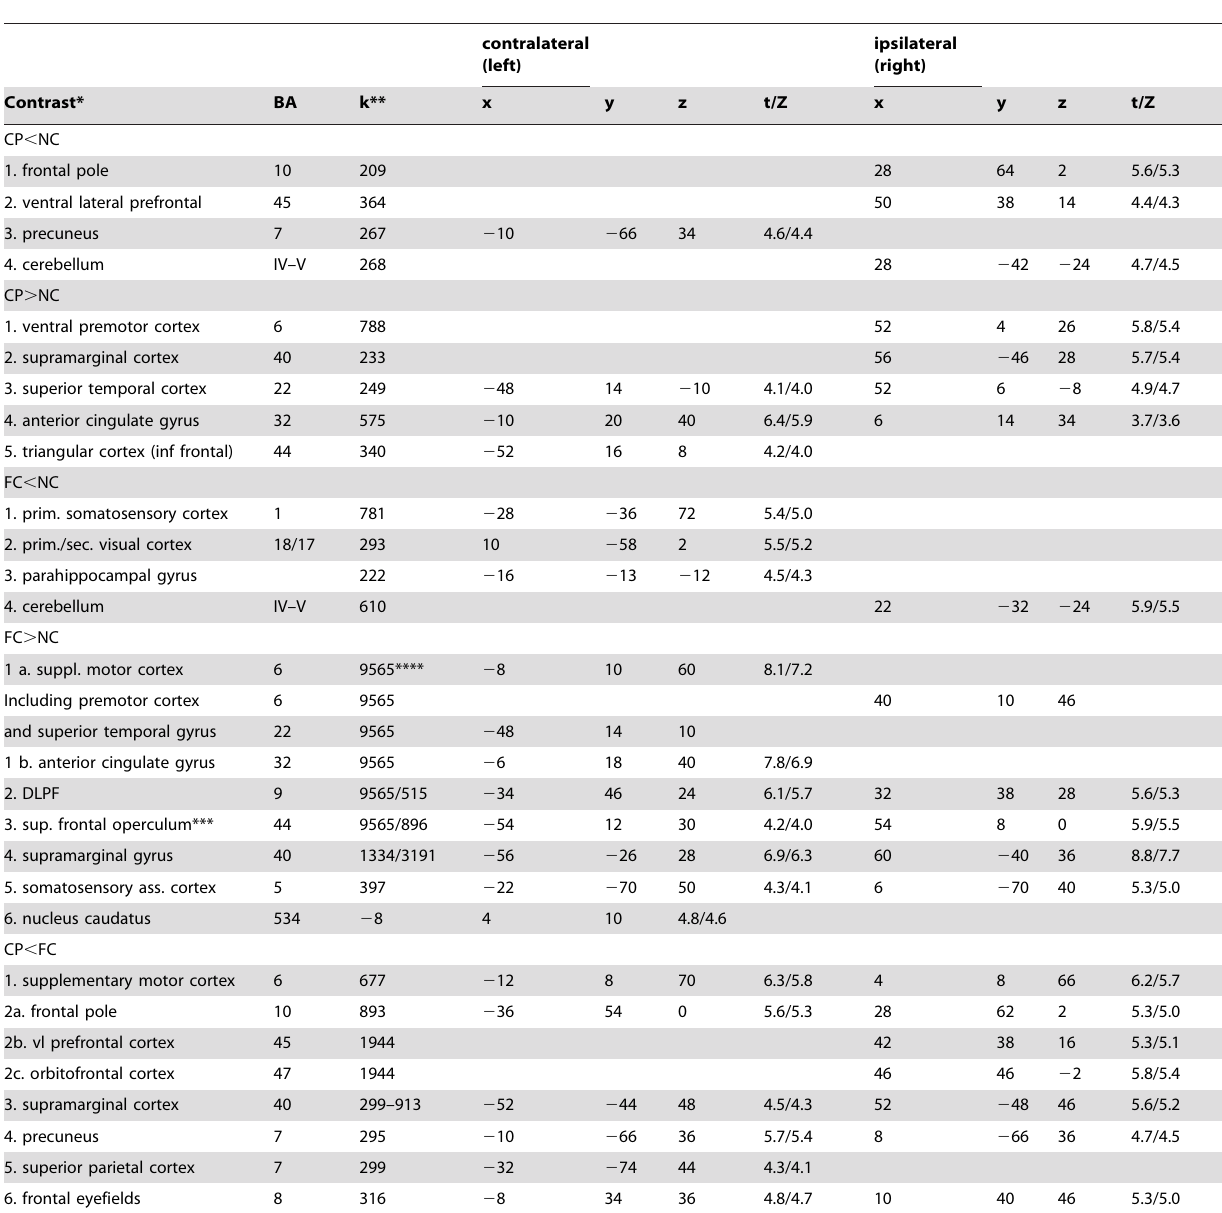
Table 5. Cerebral activation related to movement execution of the affected hand (left-sided patients and feigners were flipped).